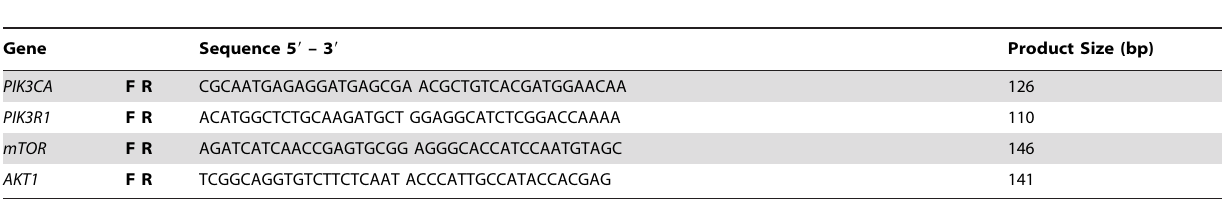
Table 1. Sequence of primers used in PCR amplification of specific target genes.